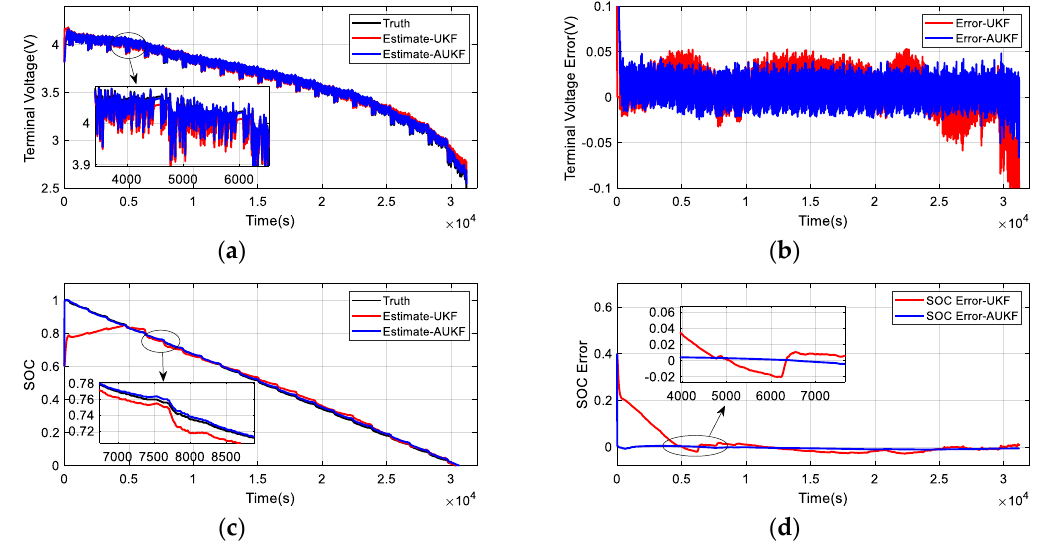
Figure 18. For the initial SOC = 0.6, the comparison of the estimation results of the UKF algorithm and the AUKF algorithm under UDDS discharge conditions. ( a ) Comparison of terminal voltage. ( b ) Comparison of terminal voltage errors. ( c ) Comparison of SOC. ( d ) Comparison of SOC errors.